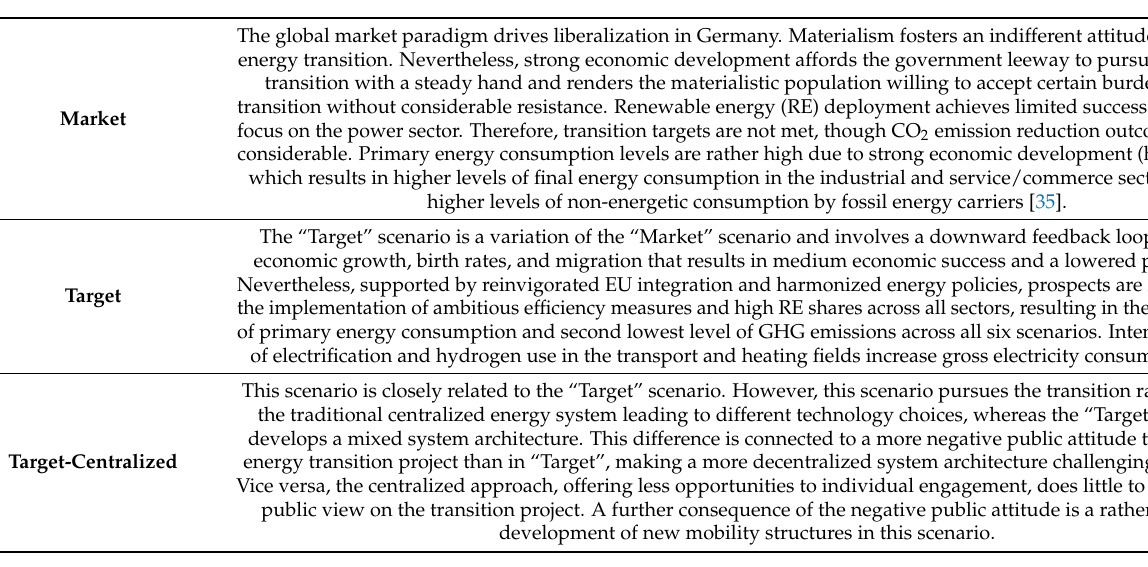
Table 1. The selected scenarios and their